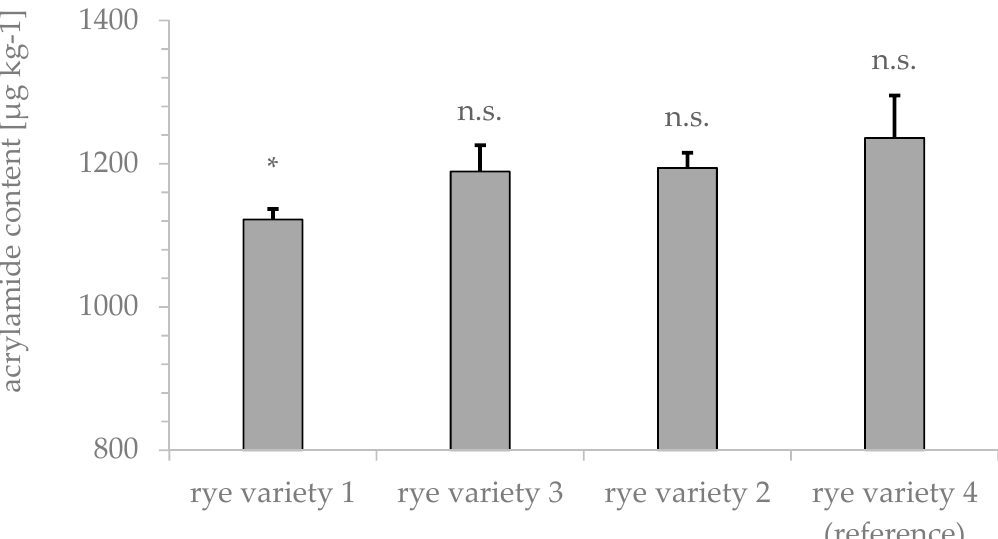
Figure 3. Acrylamide content of four different rye types analyzed by GC-MS after xanthydrol derivatization. Samples ( n = 5) were roasted at 185 °C for 20 min. * p < 0.05 indicates significant differences from the reference.